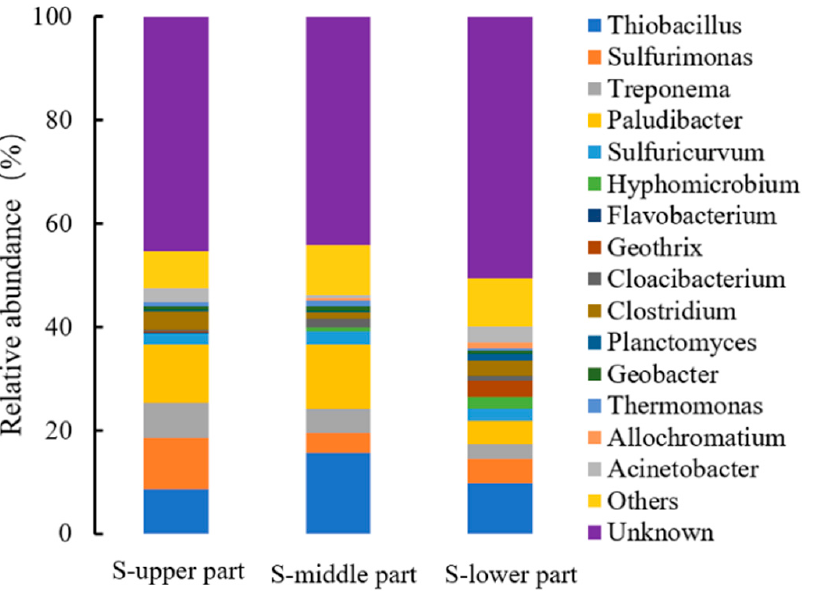
Figure 17. Microbial community structure at genus level at different heights in pilot-scale bioreactor.